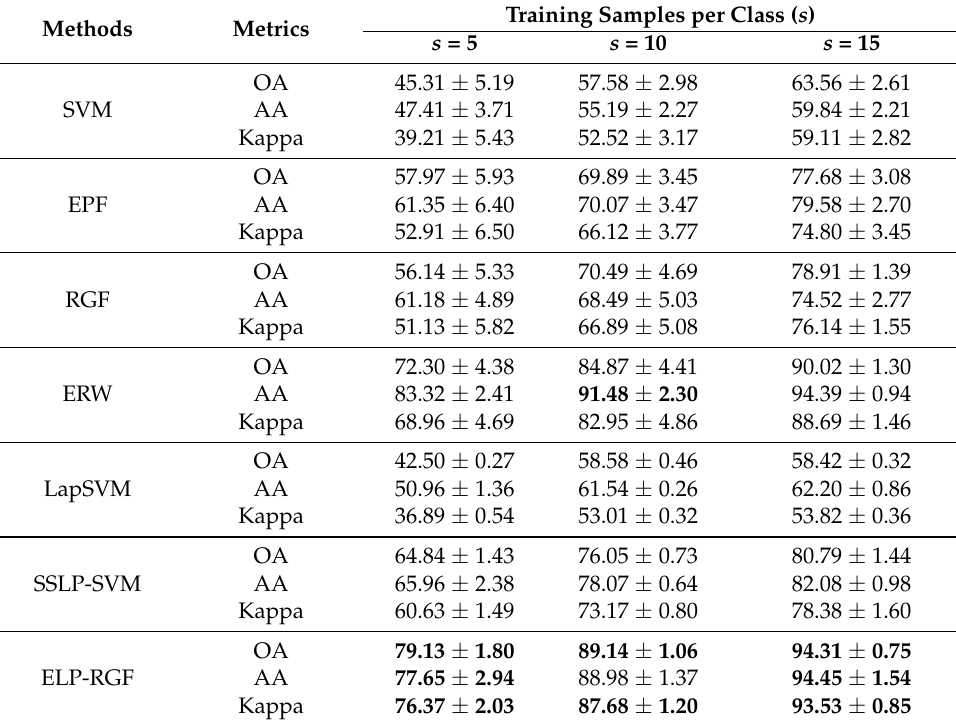
Table 1. Comparison of classification accuracies (in percentage) provided by different methods using different training samples per class (Indian Pines image). EPF, edge-preserving filtering; ERW,